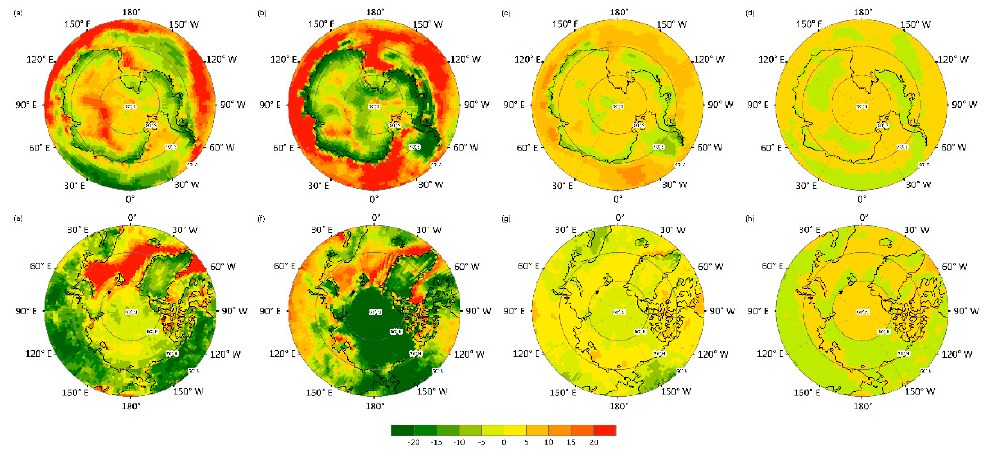
Figure 8. Seasonal geographical distribution of the di ff erent values between the BMA results and the CERES EBAF retrievals from 2000 to 2005; ( a – d ) and ( e – h ) are in local spring, summer, fall, and winter in the Southern and Northern Hemispheres, respectively (in units of W m − 2 ).